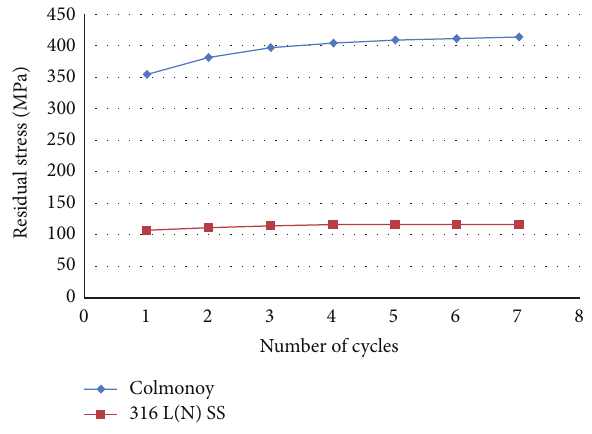
Figure 6: Convergence study of residual stress.